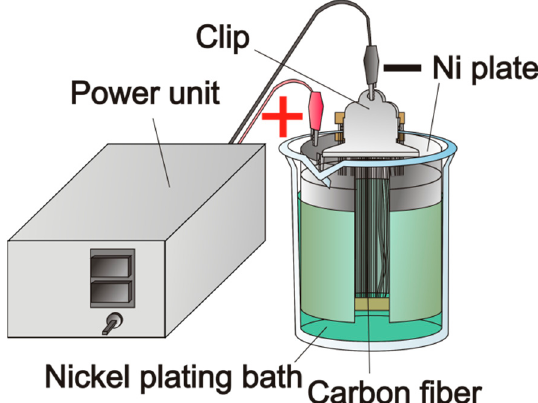
Figure 1. Schematic drawing of the Ni plating method.